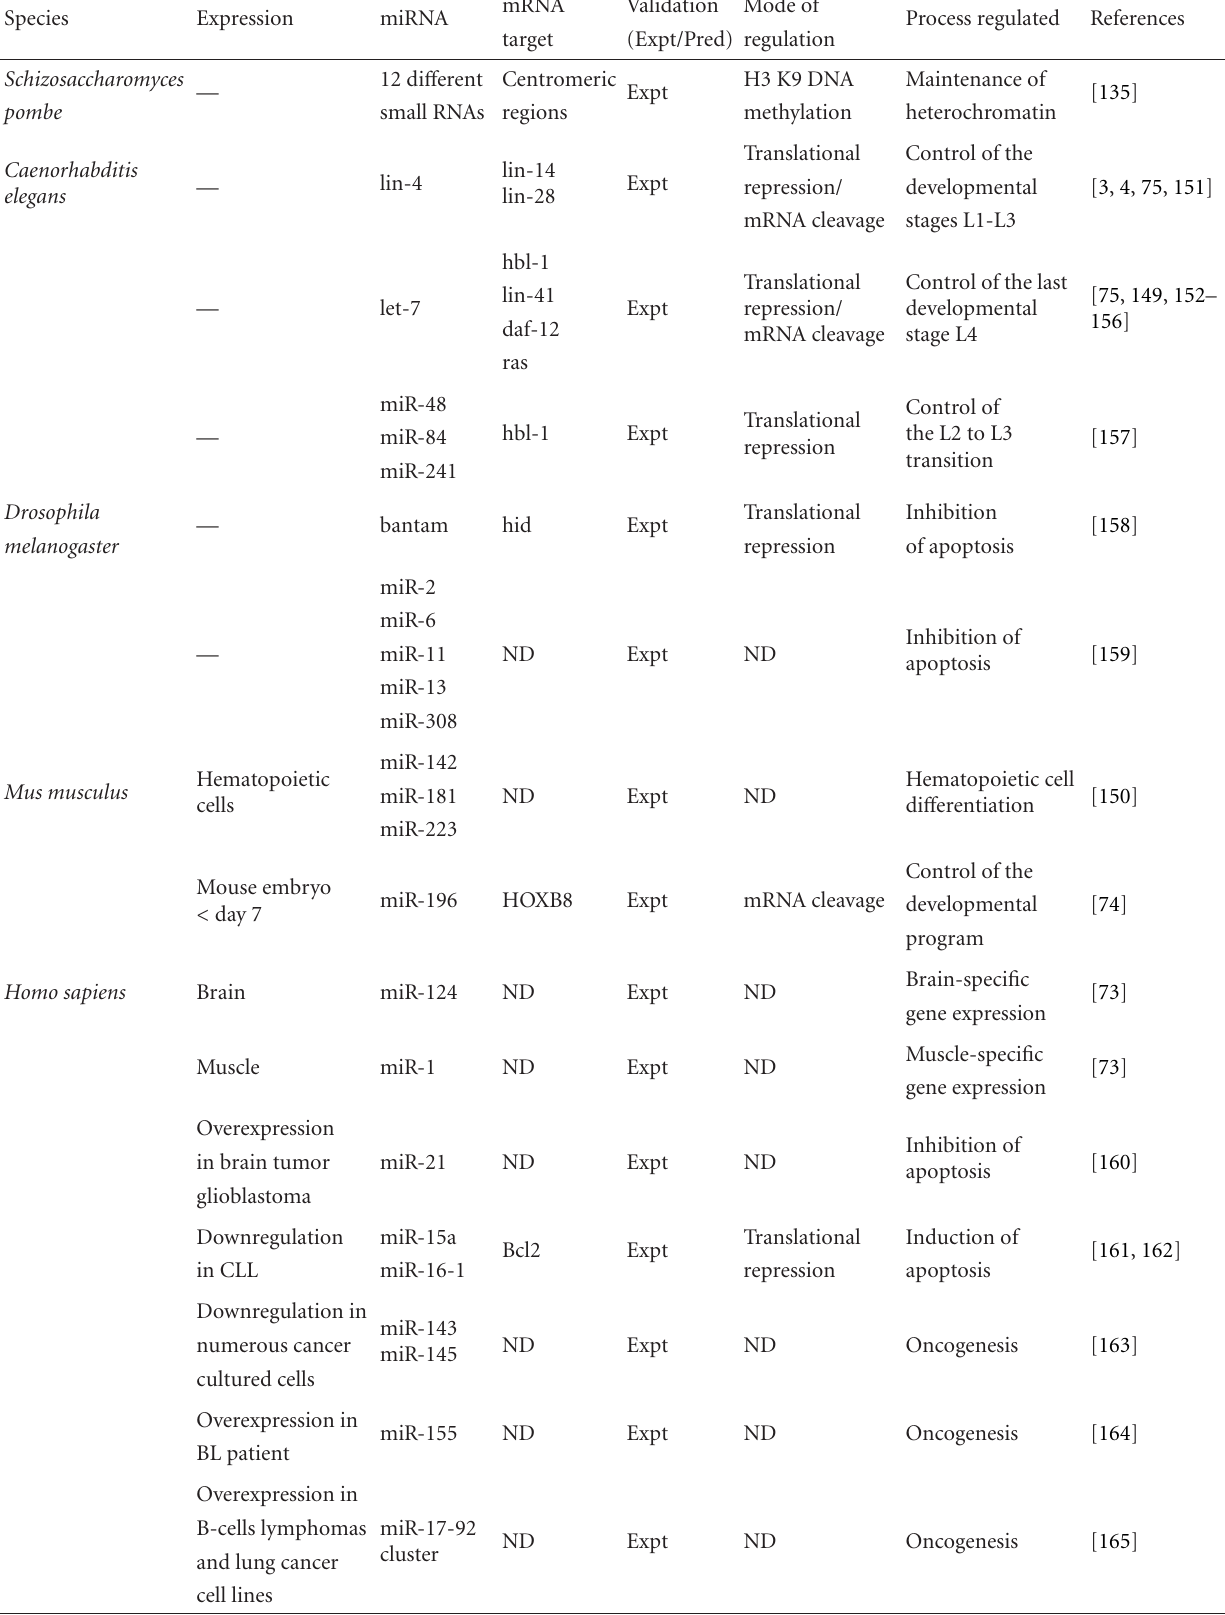
Table 2: Biological functions of miRNAs in di ff erent